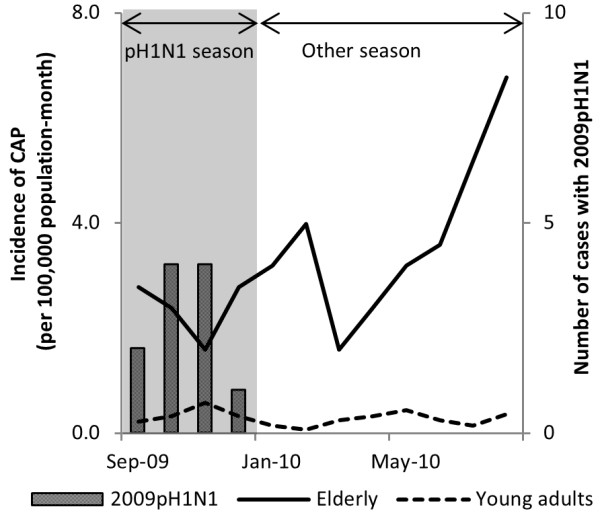
The monthly incidence of CAP amongst elderly ≥ 65 years and young adult 15–64 years and number of 2009pH1N1 influenza infections. The 2009pH1N1 season was defined between September 2009 and December 2009. The bars indicate number of 2009pH1N1 detected in our study. The estimated monthly incidences per 100,000 population amongst elderlies ≥ 65 years old were showed in solid line, those amongst young adults in dashed line.